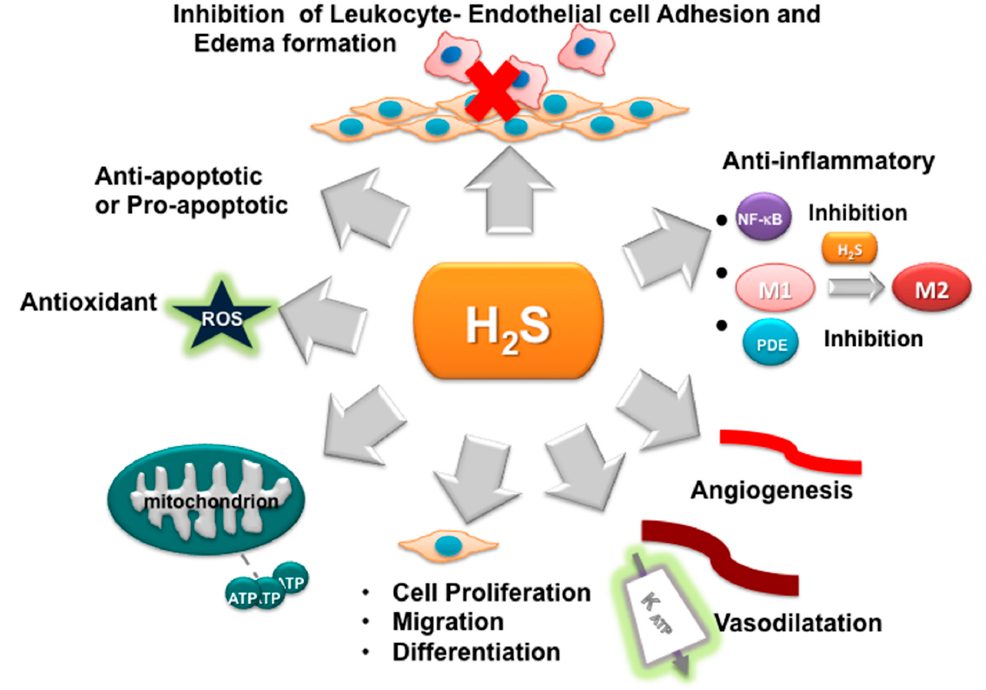
Figure 1. Schematic description of the e ff ects of H 2 S. The anti-inflammatory e ff ect of H 2 S is due to its ability to inhibit some essential pro-inflammatory transcription factors and intracellular signaling, such as nuclear factor κ B (NF- κ B) and phosphodiesterases (PDEs), and to improve angiogenesis through K ATP channel / mitogen-activated protein kinase (MAPK) pathway activation. It inhibits the production of inflammatory cytokines and avoids the adhesion of leukocytes and endothelial cells. Moreover, the gasotransmitter can have pro- or anti-apoptotic e ff ects depending on the cell type and its concentration. At the appropriate concentration, it is also able to have an anti-apoptotic e ff ect due to its antioxidant properties, as well as its ability to increase the mitochondrial activity and the expression of anti-apoptotic proteins [17]. However, exogenous H 2 S is also able to induce apoptosis in cancer cells. H 2 S can also act on the vascular smooth muscle producing vasodilation. M1, macrophages M1; M2, macrophages M2; K ATP , ATP-dependent K